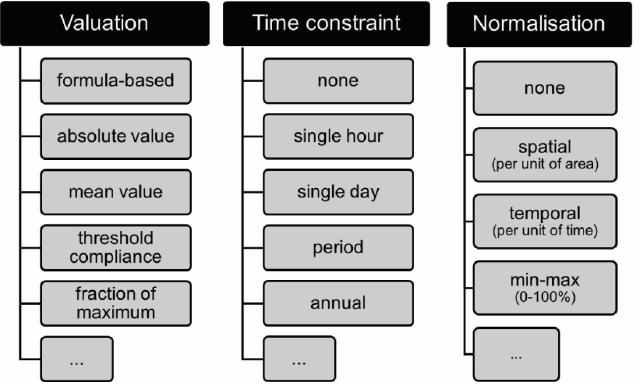
Figure 2. The three metric characteristics that should constitute the metric formulation principles, including commonly found